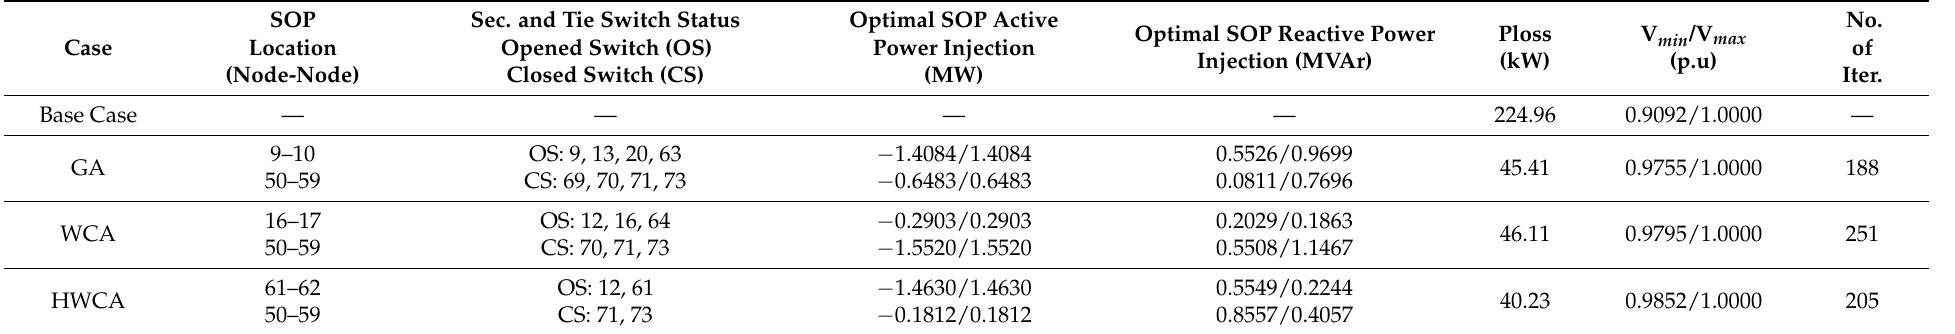
Table 6. Compared numerical results of HWCA for case 7 with WCA and GA for the 69-node